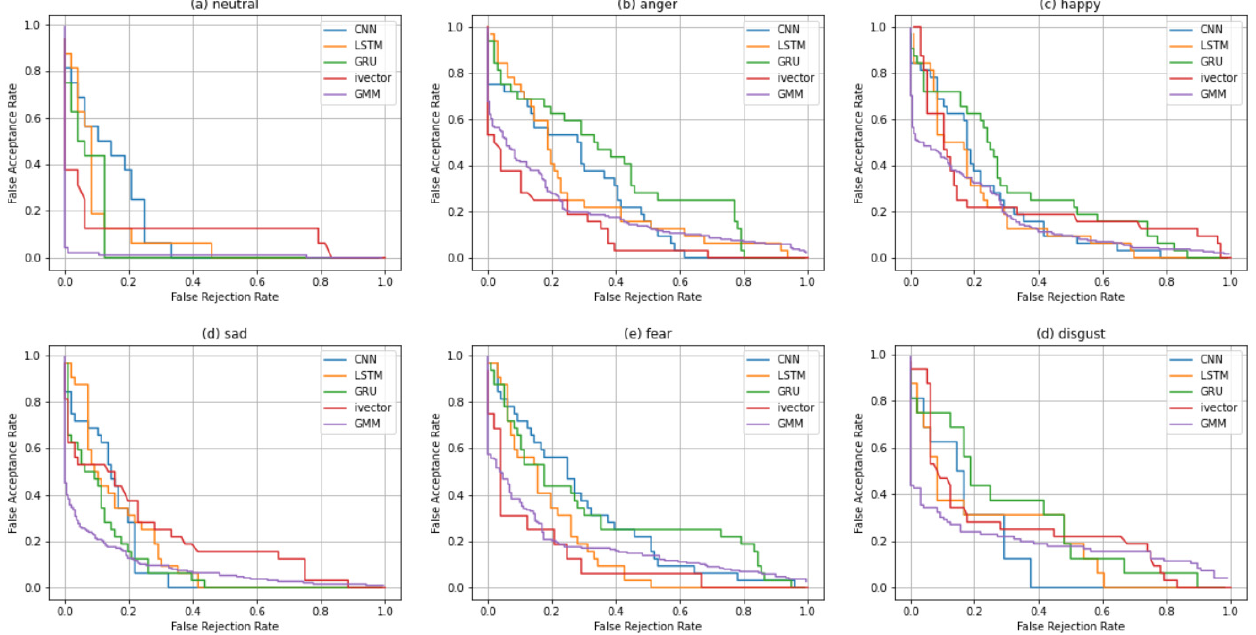
Figure 11. DET curves of RAVDESS database based on CNN, LSTM, GRU, i vector, and GMM.